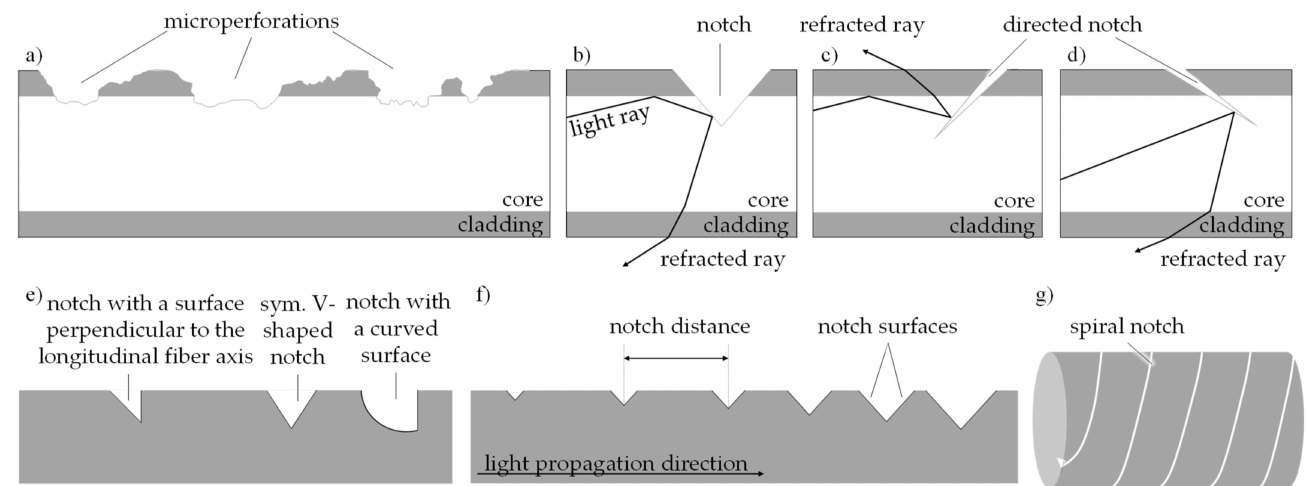
Figure 5. Different forms of surface perforations: ( a ) random microperforations, ( b ) V-shaped notch, ( c ) and ( d ) directed notches, ( e ) different notch shapes, ( f ) varying notch distances and surfaces for gradual sidelight activation, ( g ) continuous spiral